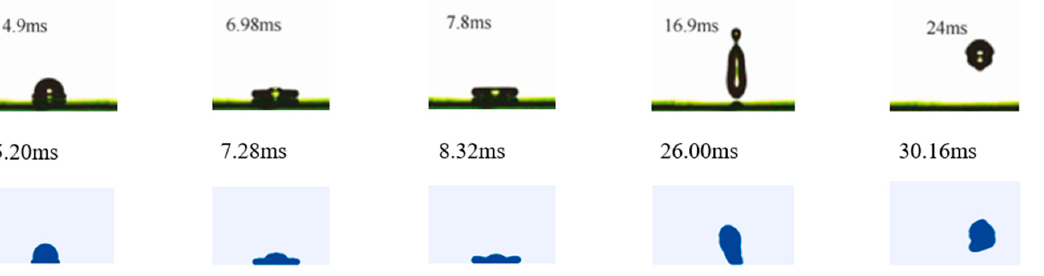
Figure 7. Comparison between numerical simulation and experimental results of Motion Model.